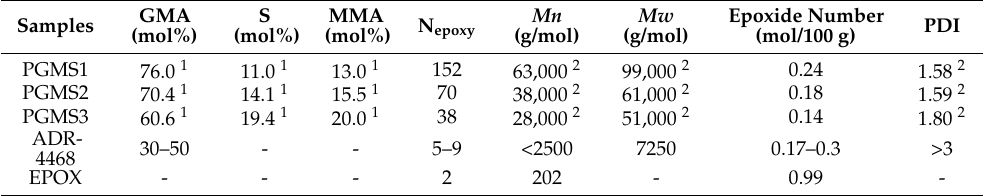
Table 2. Chemical composition, molecular weights, and PDIs of five chain